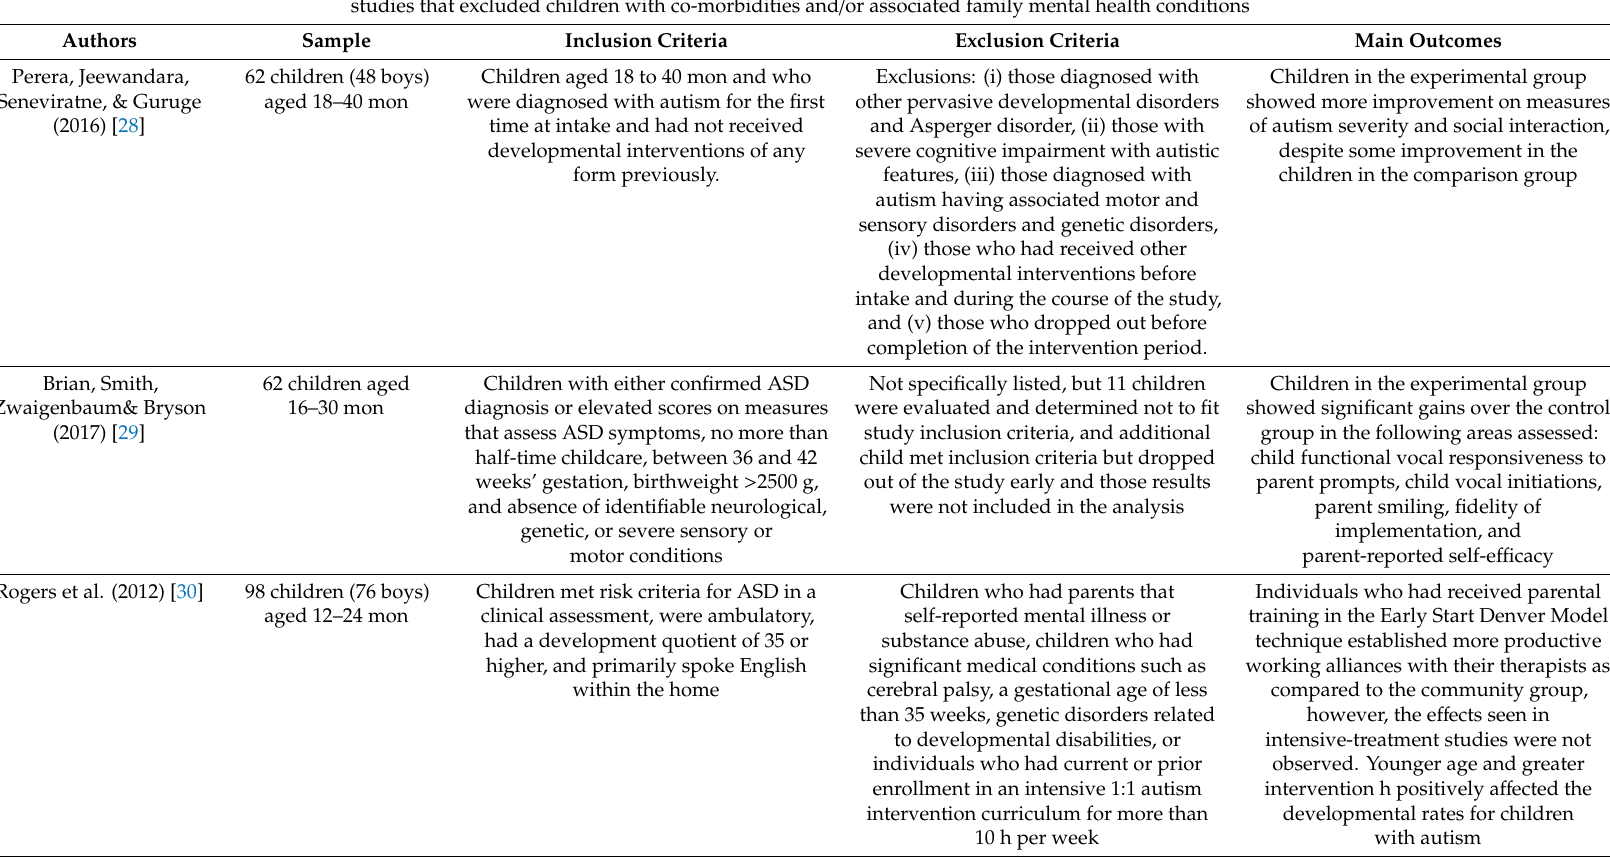
Table A1. Summary of early-intervention studies